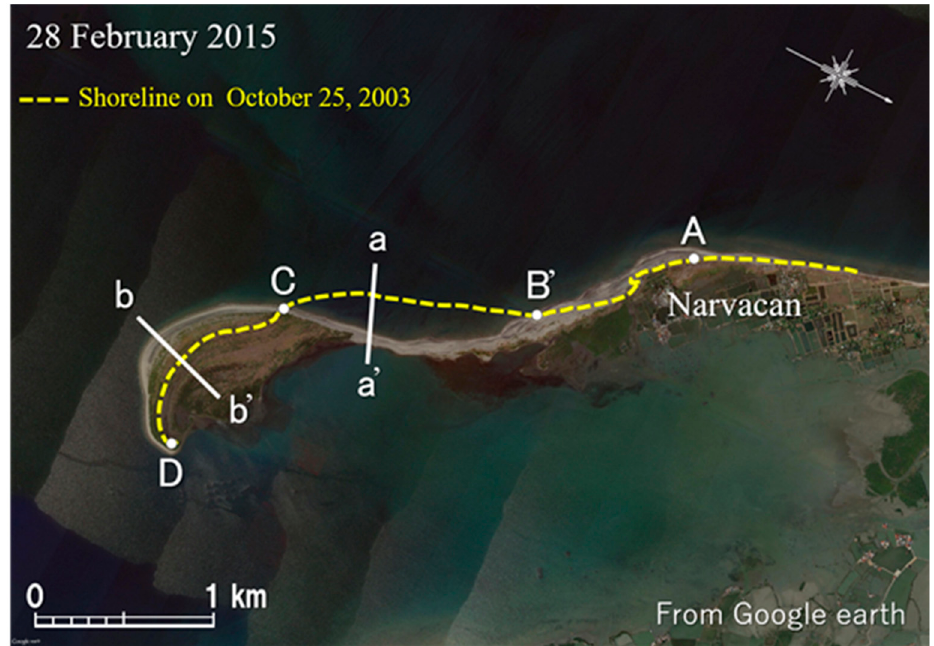
Figure 25. Satellite image around the sand spit at Santo Tomas (28 February 2015).